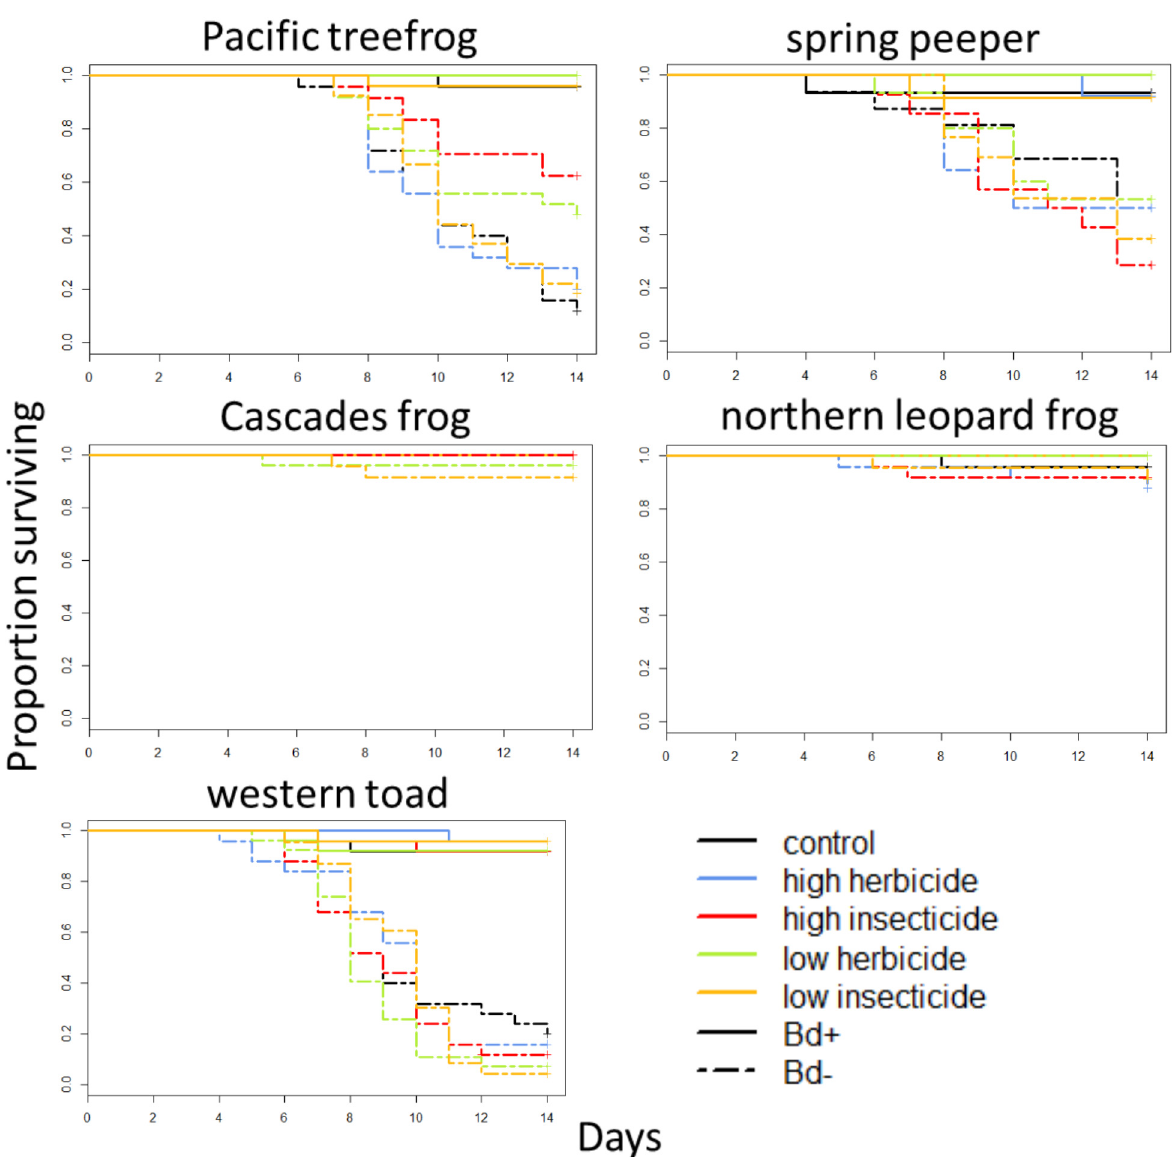
Fig 3. Survival of amphibians exposed to pesticides as metamorphs. Species are arranged phylogenetically (rows) and by geographic origin (columns). Dashed lines indicate Bd-exposed individuals, and solid lines indicate Bd-unexposed individuals.